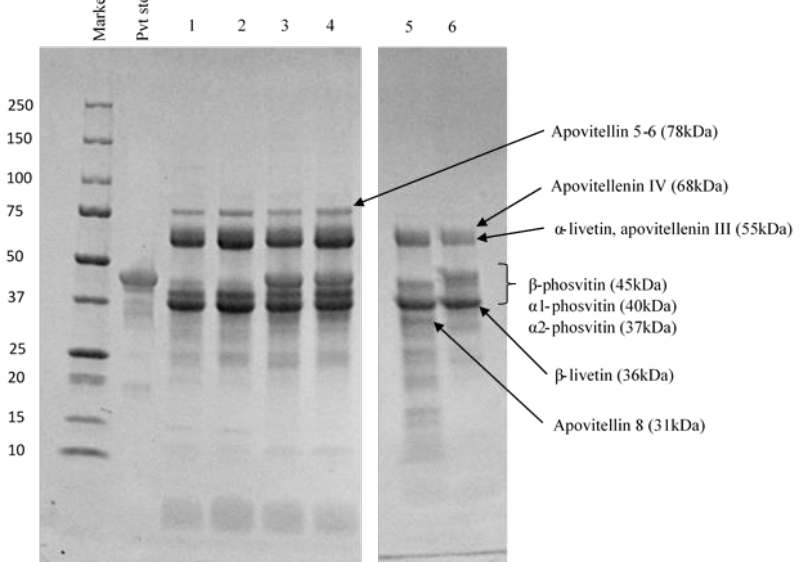
Figure 7. Protein profiles by SDS-PAGE of the cream and aqueous phases of emulsions from control UF_retentate and UF-retentate of plasma from pressure treated granules. Pvt Std: commercial phosvitin standard, 1: control emulsion, 2: control aqueous phase, 3: emulsion containing UF-retentate of plasma from pressure-treated granules, 4: aqueous phase of emulsion containing UF-retentate of plasma from pressure-treated granules, 5: control cream, 6: cream from emulsions containing UF-retentate of plasma from pressure-treated granules.